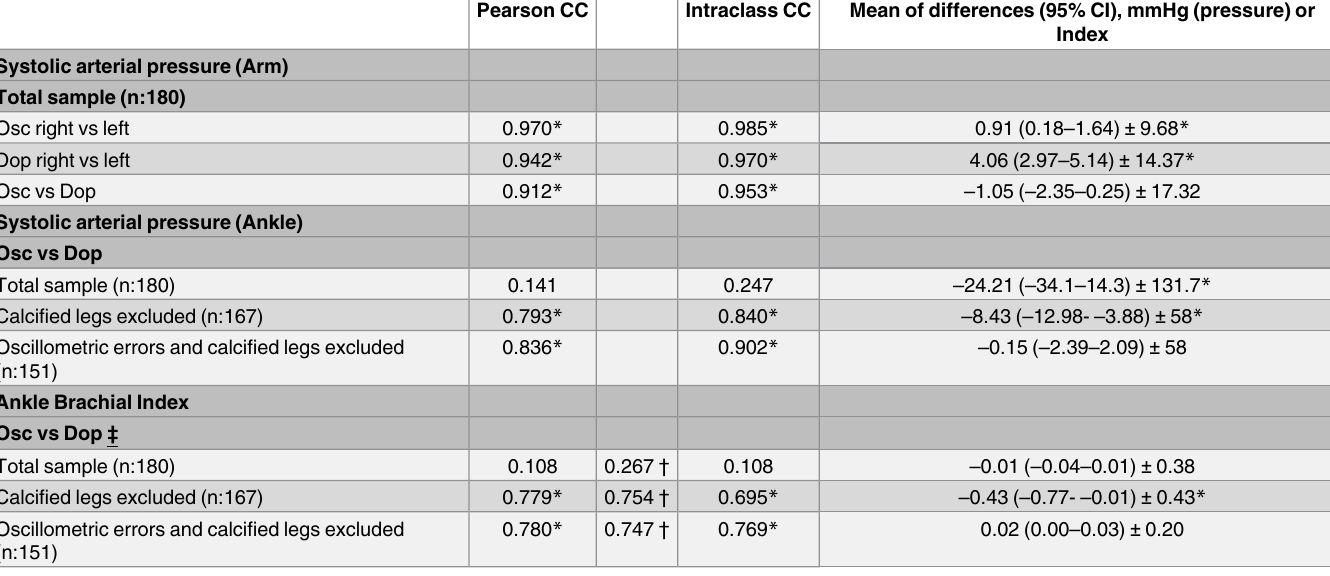
Table 2. Correlation and level of agreement in the pressuresof arm, ankle and ABI for Doppler and